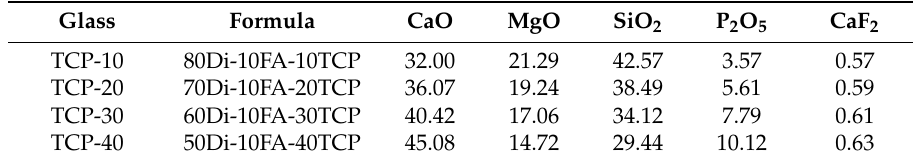
Table 11. Batch compositions of the glasses within Di–FA– tricalcium phosphate (TCP) ternary system (mol